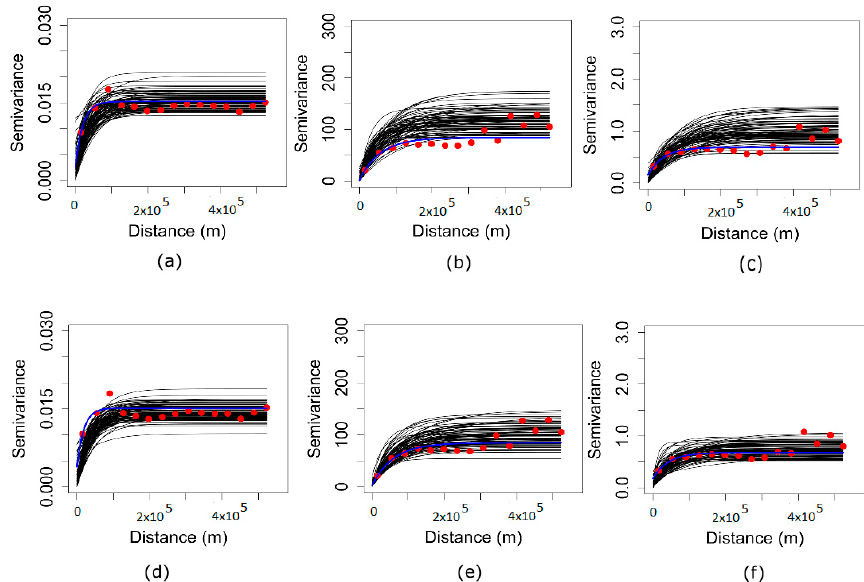
Figure 9. Approximate spatial orthogonality for the MAF factors and ICA components. According to Tercan [29], it is ideal if τ (h) = 0 and k(h) = 1.